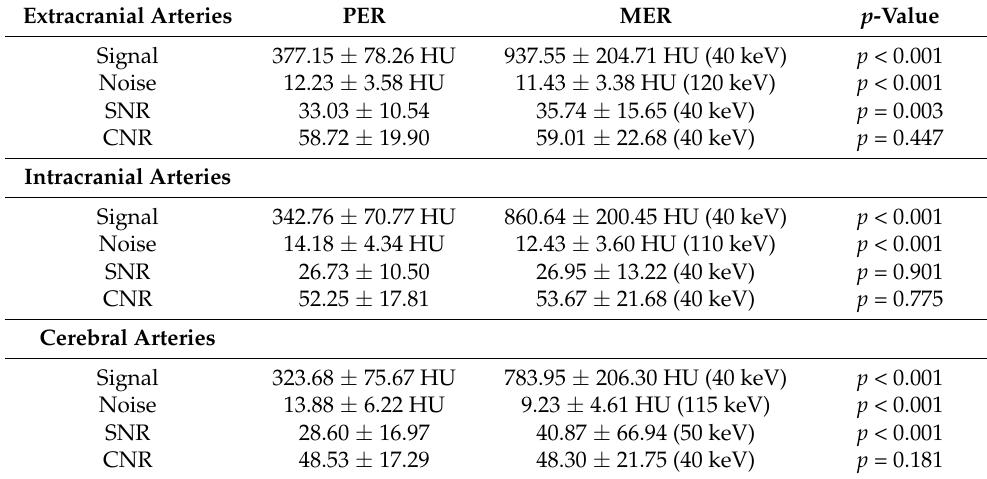
Figure 6. Contrast-to-noise ratio, mean ± SD. HU: Hounsfield units; PER: polyenergetic reconstruc- tion; keV: keV level of the monoenergetic reconstruction. Extracranial: internal carotid artery C1 segment and vertebral artery V3 segment; intracranial: internal carotid artery C4 segment and basilar artery; cerebral: ACA, MCA and PCA. Table 1. Comparison of the polyenergetic reconstruction and the best monoenergetic reconstruc- tions.